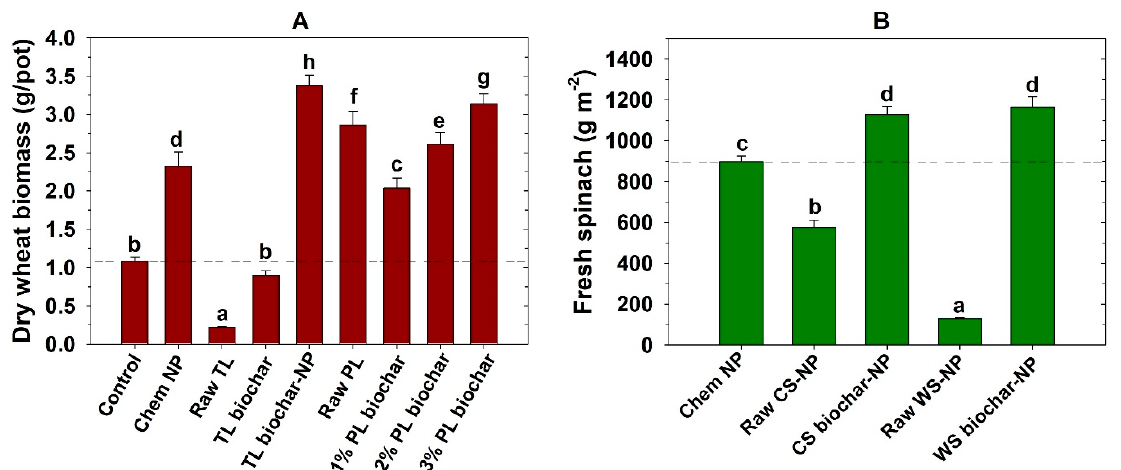
Figure 2. Biomass production of ( A ) winter wheat and ( B ) spinach in a sandy loam amended with biochars derived from different organic residues at varied amendment rates. Data are means of triplicate measurements. Error bars represent standard deviation of triplicate measurements. TL—tree